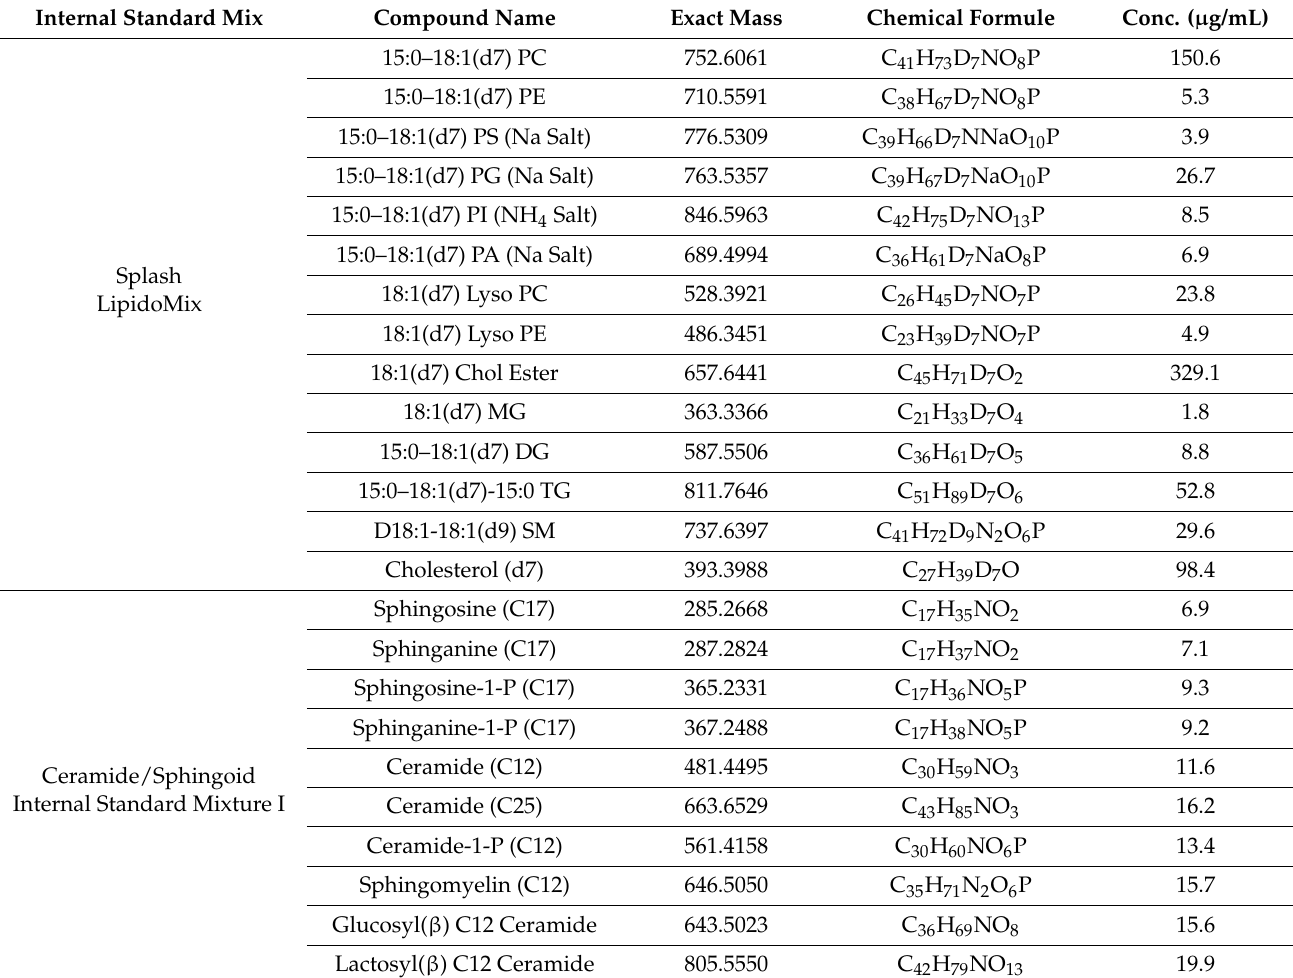
Table 2. Lipid composition of the internal standard